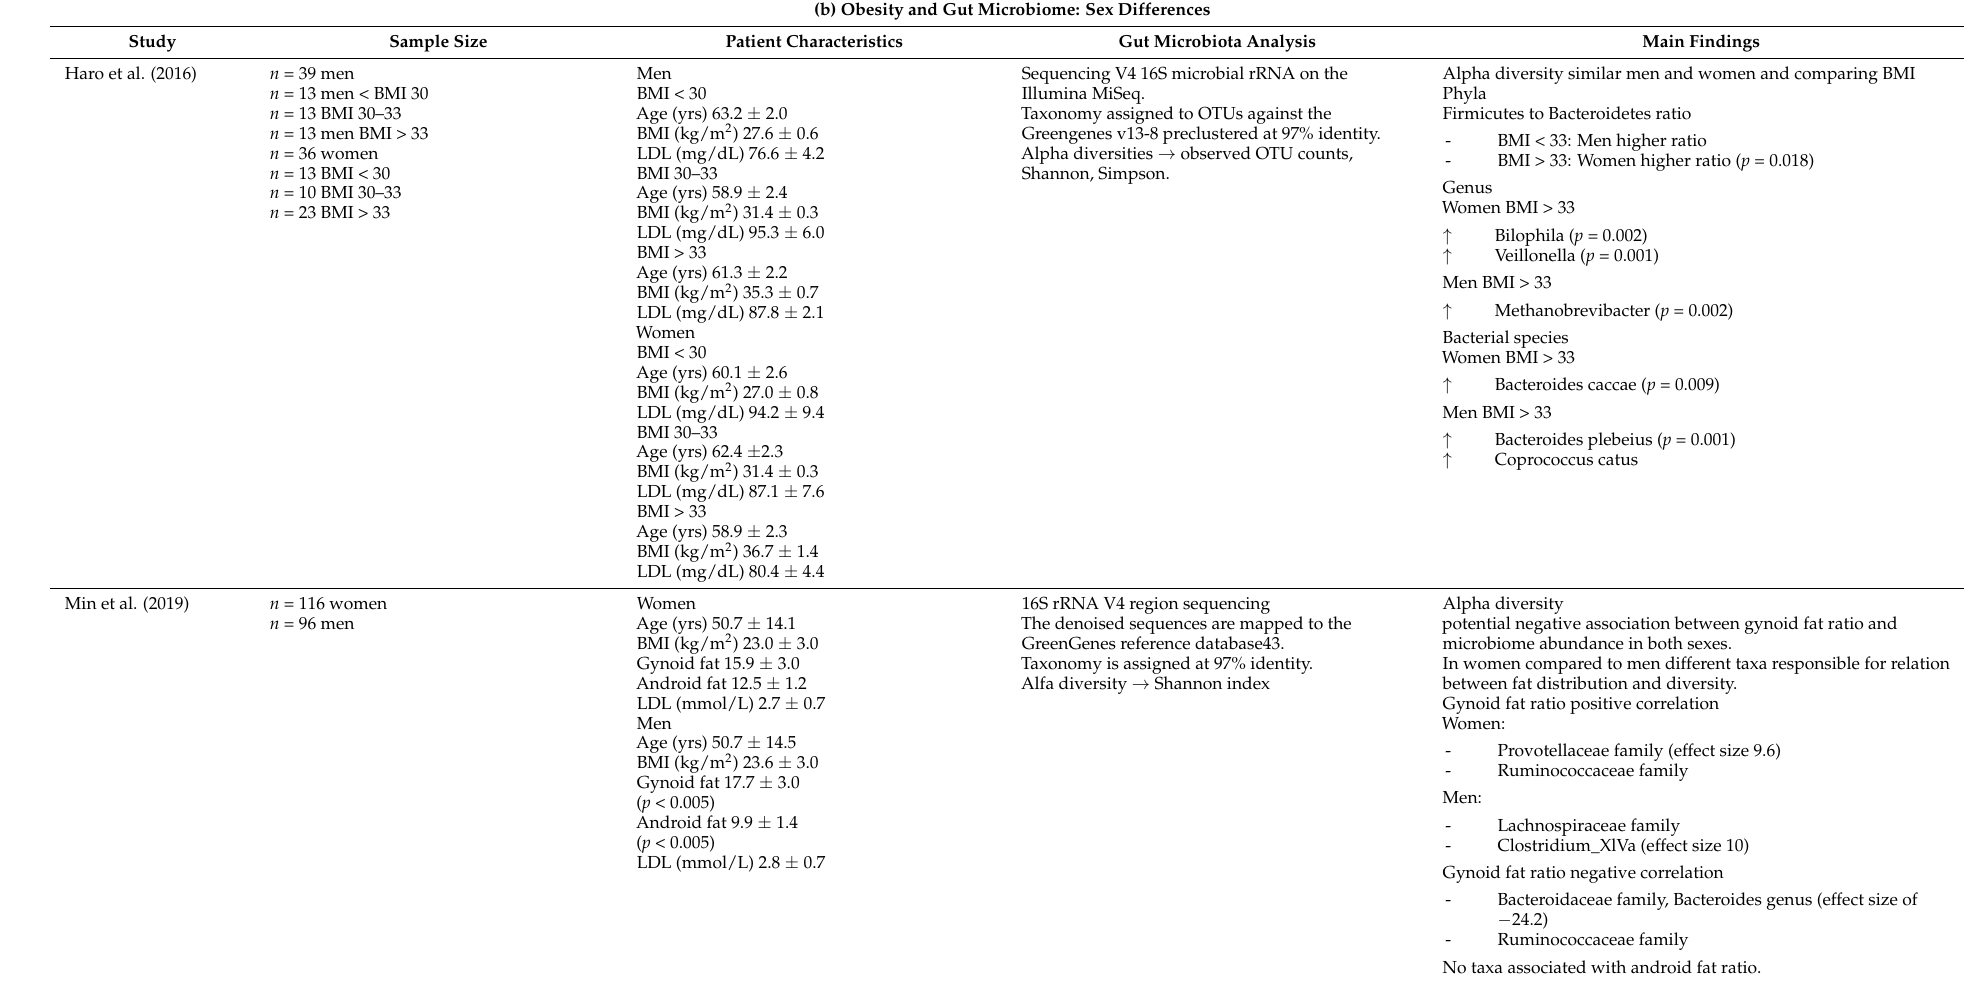
(b) Obesity and Gut Microbiome: Sex